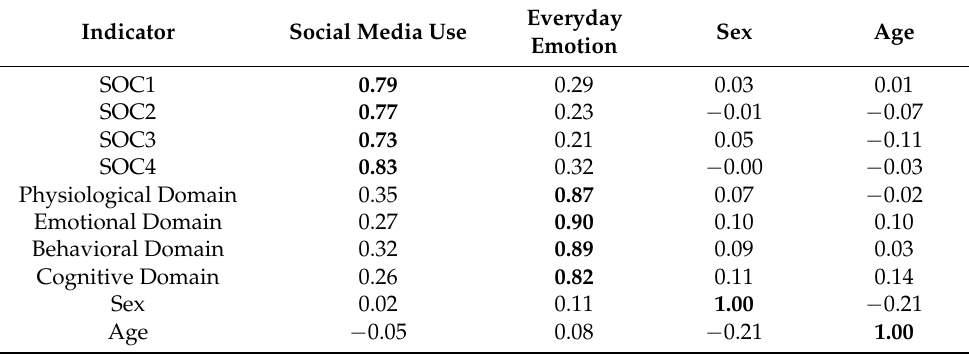
Table 7. Loadings and cross-loadings for the outer